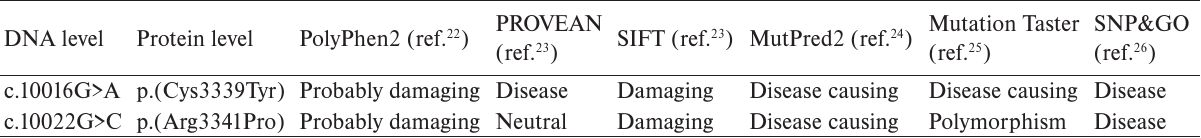
table 3. In silico analysis of two missense variants in ZNF469